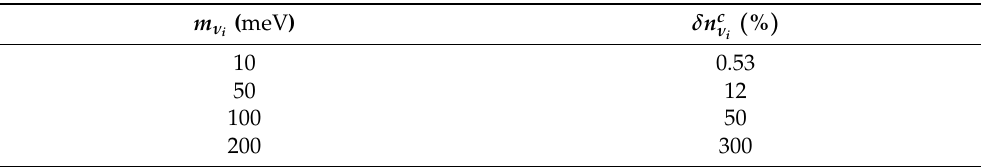
Table 8. The enhancement factor, δ n c ν for given values of neutrino masses